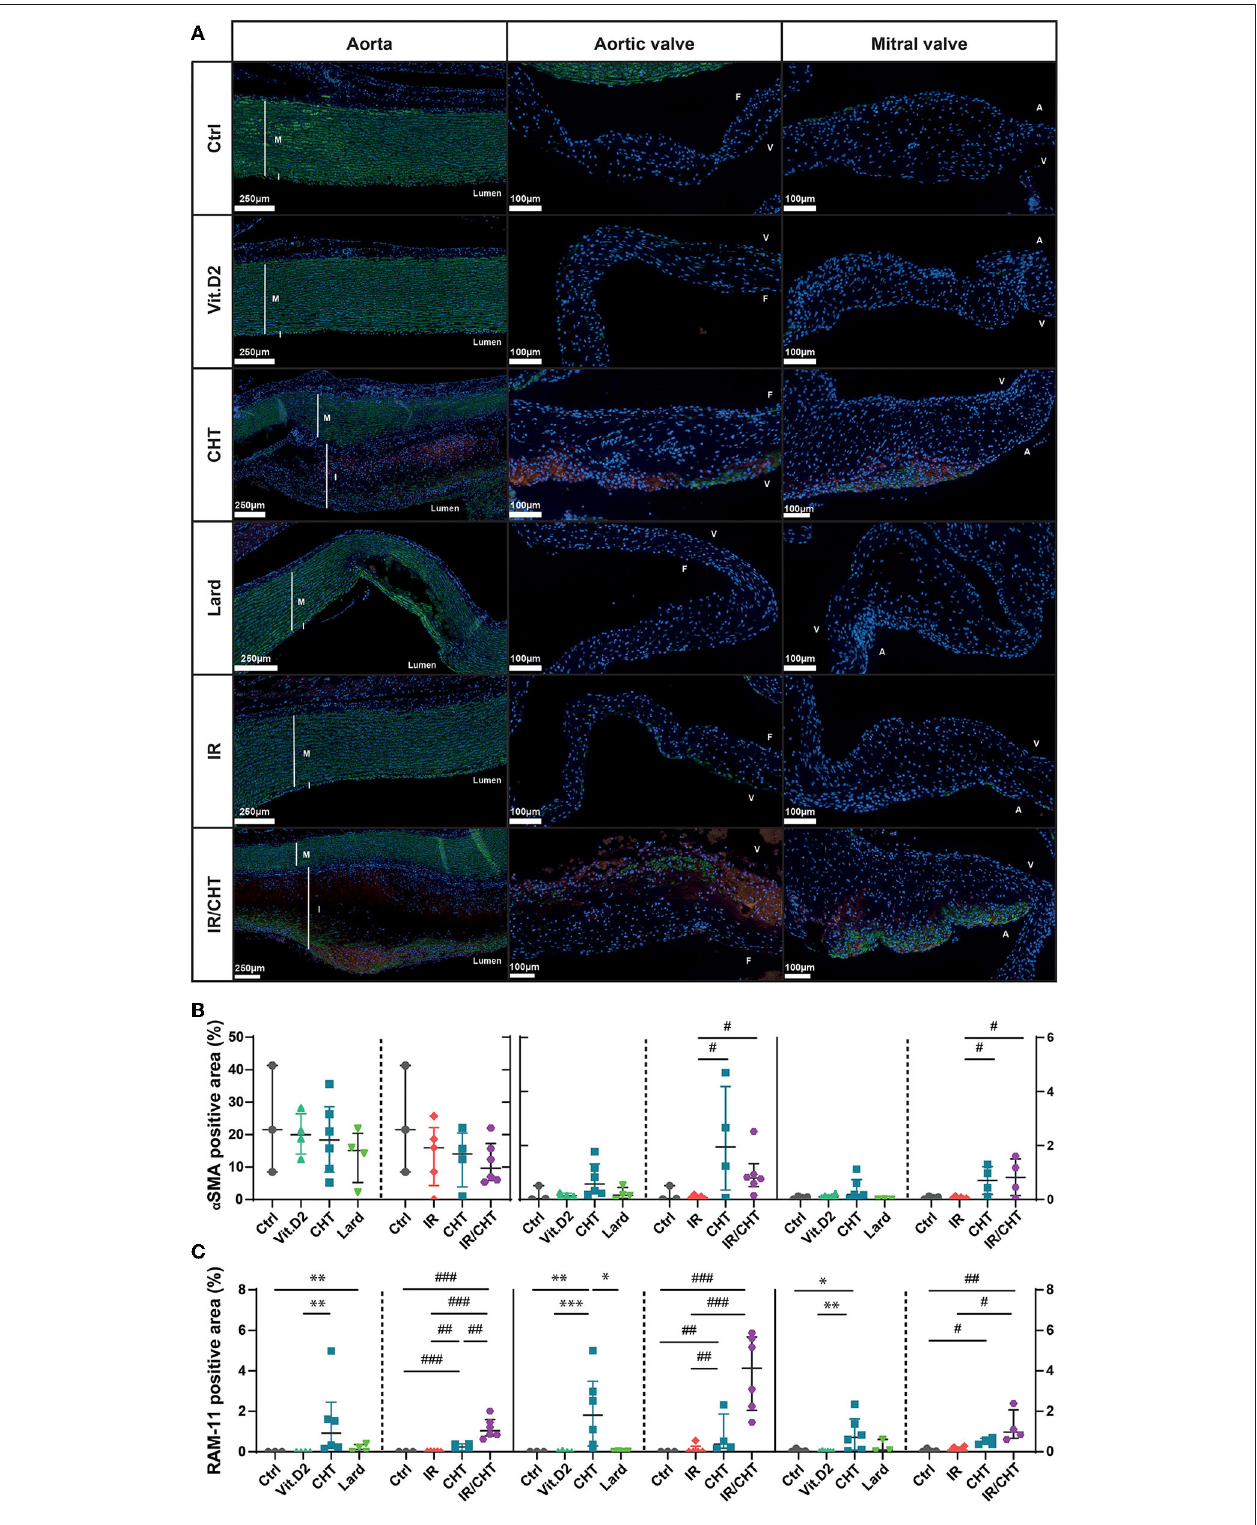
FIGURE 4 | Immuno-detection of RAM-11- and α SMA positive cells in the aorta and heart valves. (A) Representative pictures of RAM-11 and α SMA immunofluorescence costaining performed on the aorta, the aortic valve, and the mitral valve sections. Nuclei are stained with DAPI and appear in blue. α SMA-